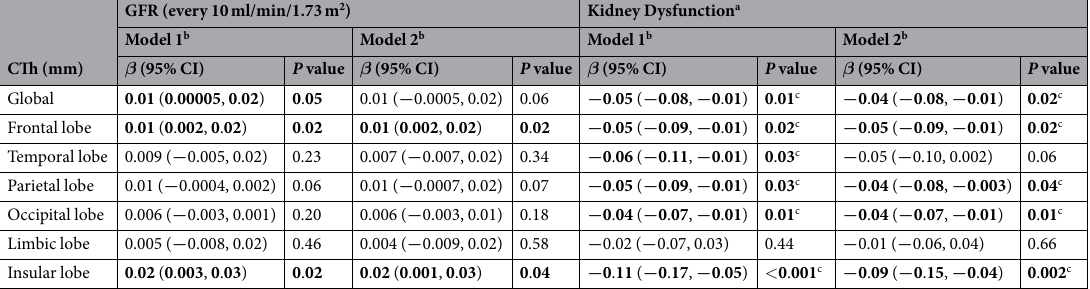
Table 2. Association between kidney function and CTh by multiple linear regression models. a Kidney dysfunction is defined as either GFR < 60 ml/min/1.73 m 2 or presence ( ≥ 1 + ) of proteinuria. b Model 1 was adjusted for age, gender, education years, APOE ε 4 carrier status, MoCA-T score, and intracranial volume; Model 2 was additionally adjusted for degree of white matter lesion, lacunes, hypertension, diabetes mellitus, body mass index, and smoking. c False discovery rate q value < 0.05. Numbers in bold indicated significant findings (before correction for multiple comparisons).